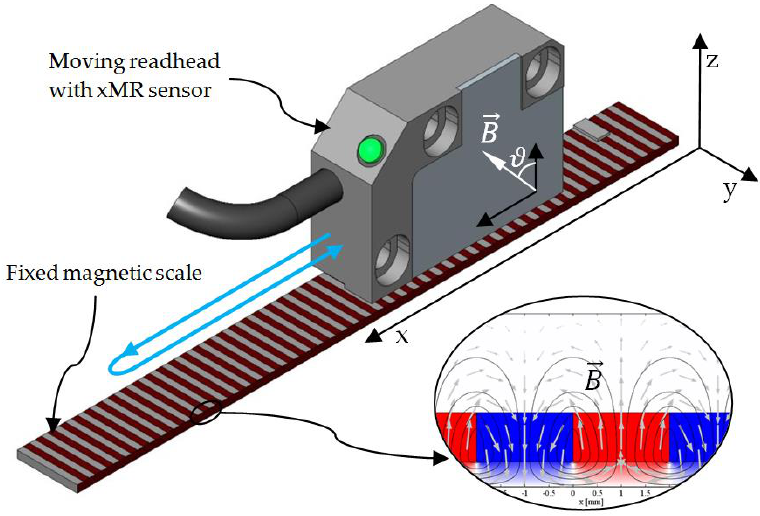
Figure 4. The setup of a linear encoder. A read-head with xMR sensor moves along the x axis above the magnetic scale with alternating poles, magnetized up and down along the z axis and thus providing a magnetic field in interchanging direction. The movement during the calibration is indicated with the blue line.